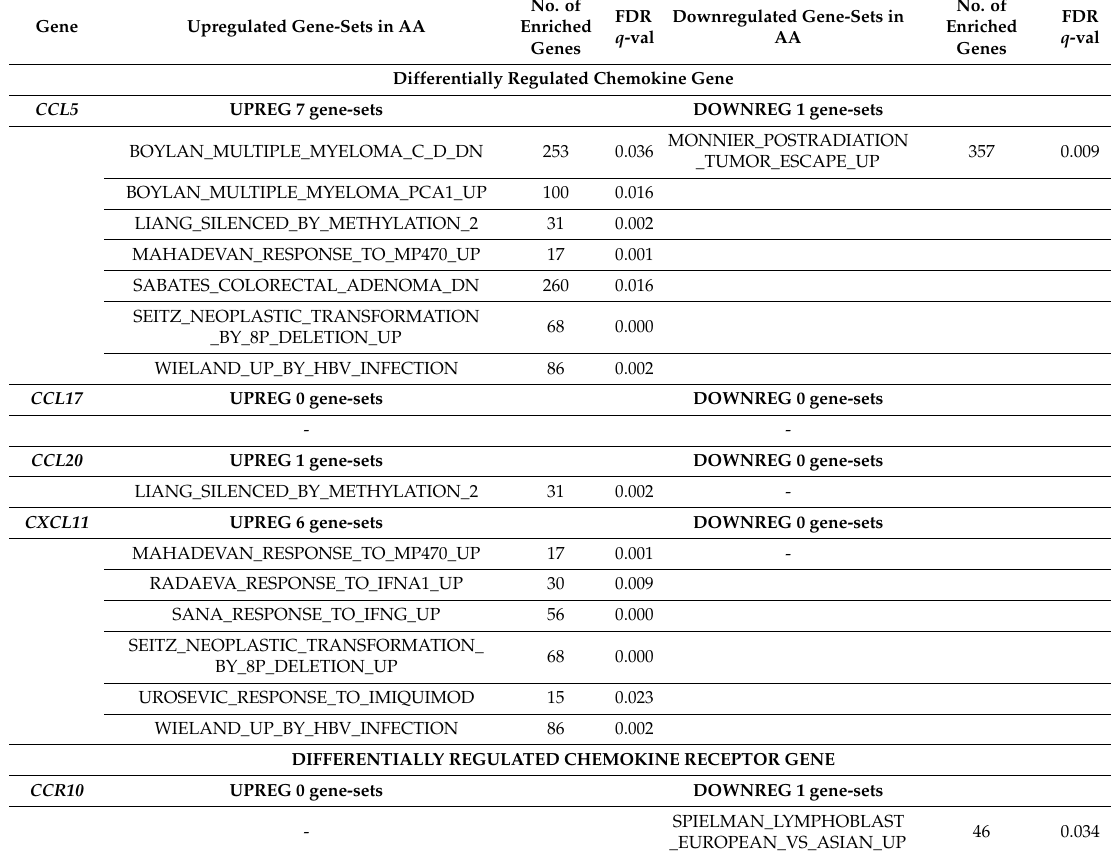
Table 3. Differentially regulated gene sets associated with differentially regulated individual chemokine and chemokine receptor genes in the distal colon 28 days